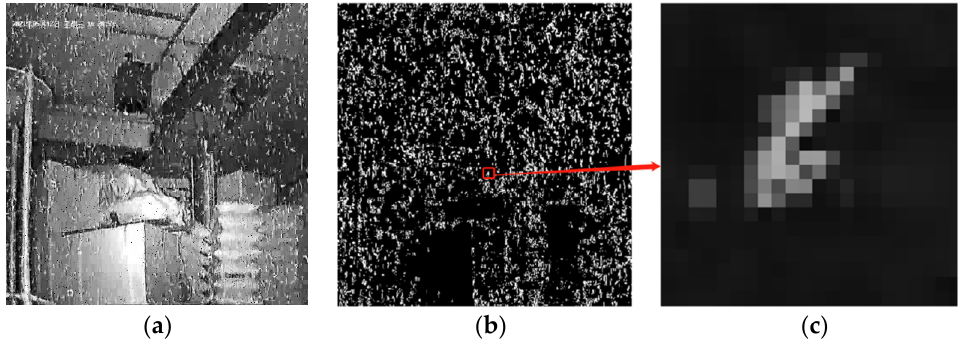
Figure 1. Detection and extraction of noise : ( a ) Images of radiation contamination; ( b ) Binarization image of noise position; and ( c ) Individual noise contour.